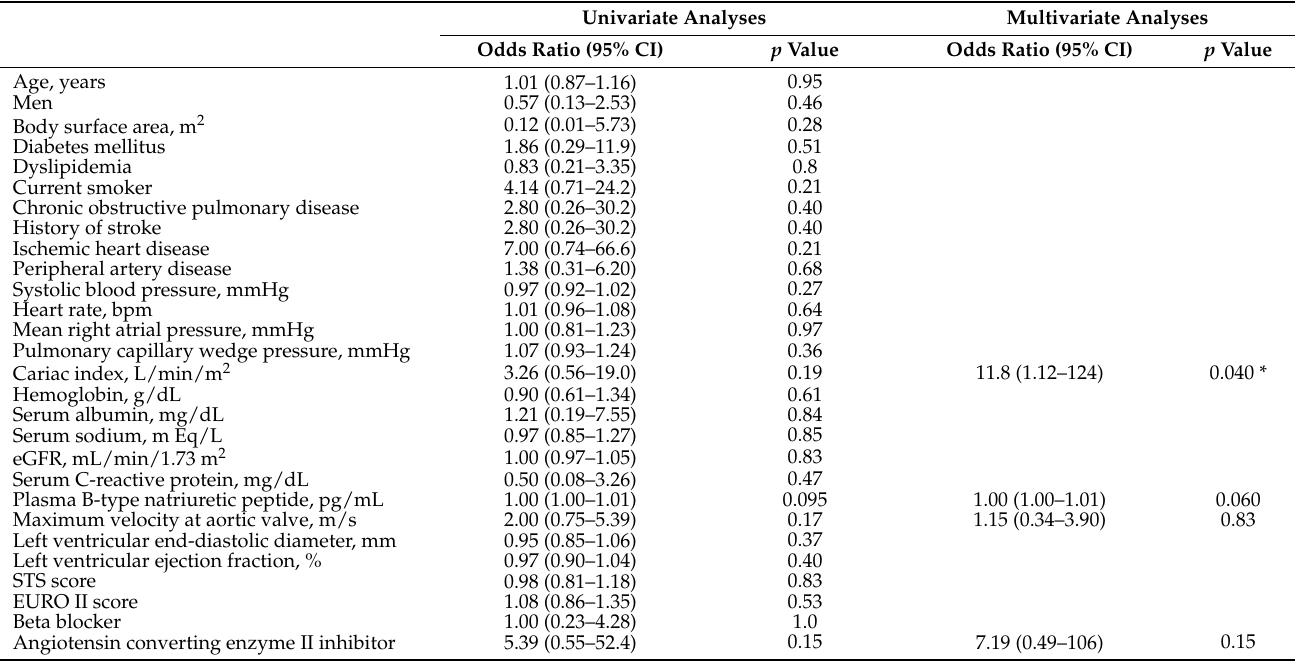
Table 3. Predictors of the normalization of FMD following